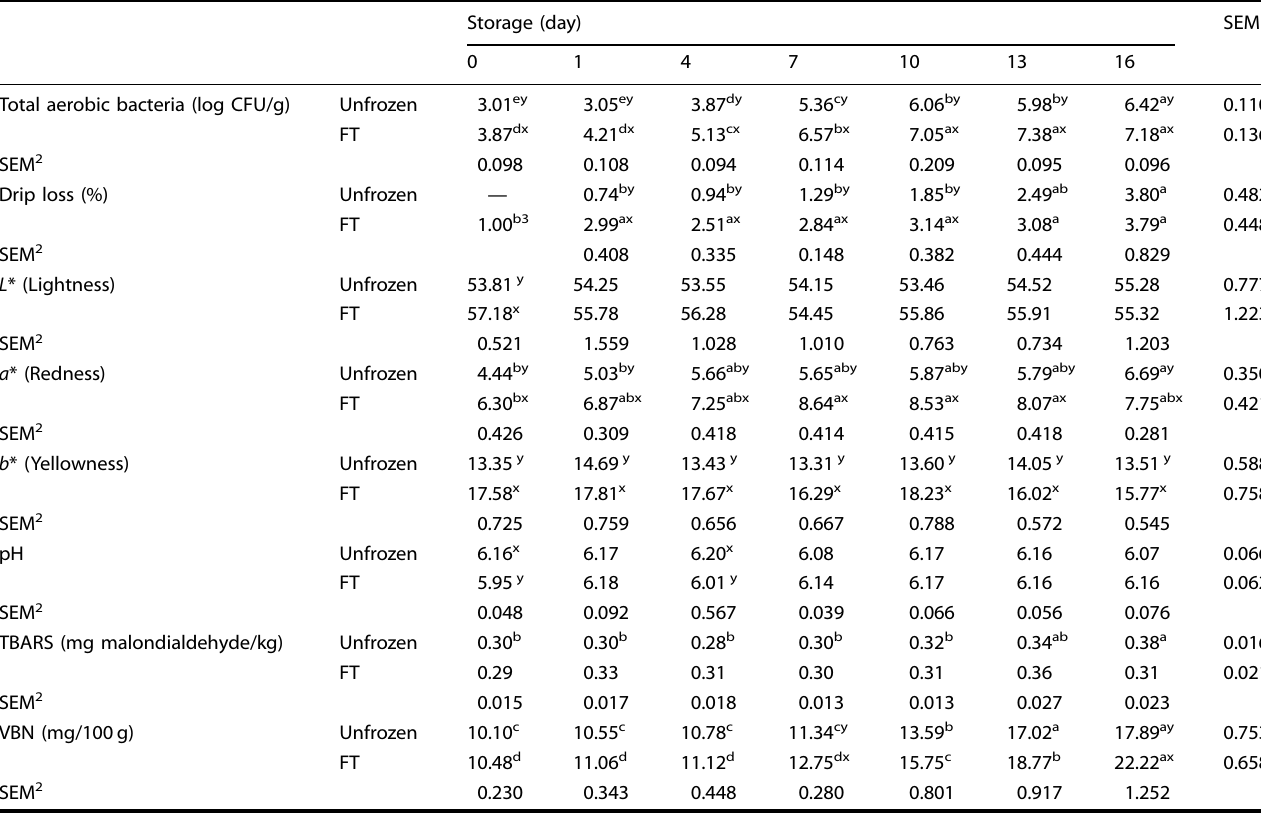
Table 1. Total aerobic bacteria and physicochemical properties of unfrozen and frozen/thawed (FT) chicken breast meat during storage. Storage (day) SEM